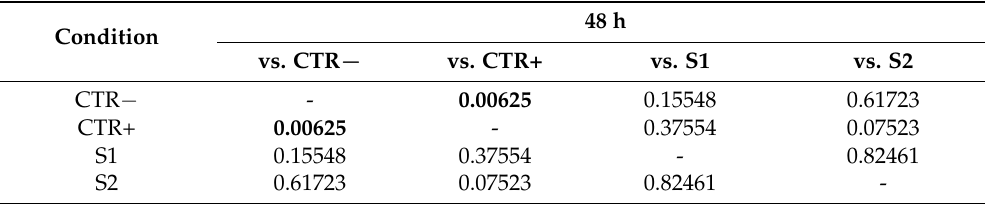
Table 5. ANOVA and Tukey-Kramer test statistical analysis of IL-8 levels in CTR − , CTR+, S1 and S2 tissues at 48 h (statistically significant values in bold, p < 0.05).